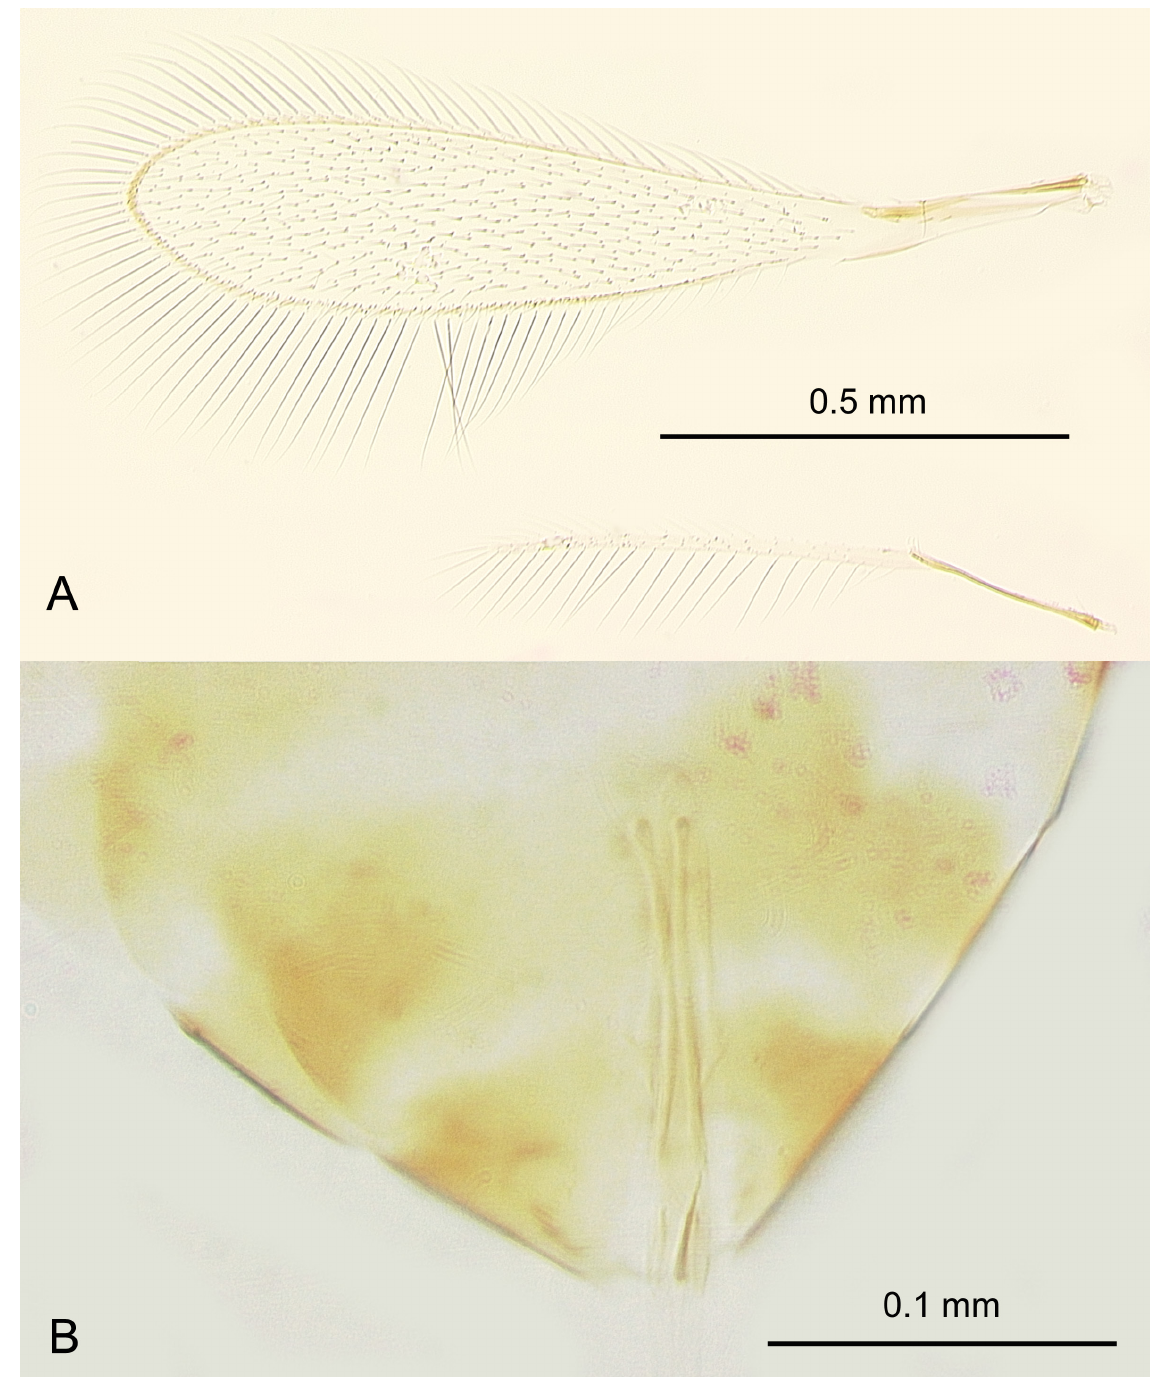
Fig. 12. Ganomymar libertatium sp. nov., ♂, paratype (CAS). A . Fore and hind wings. B .